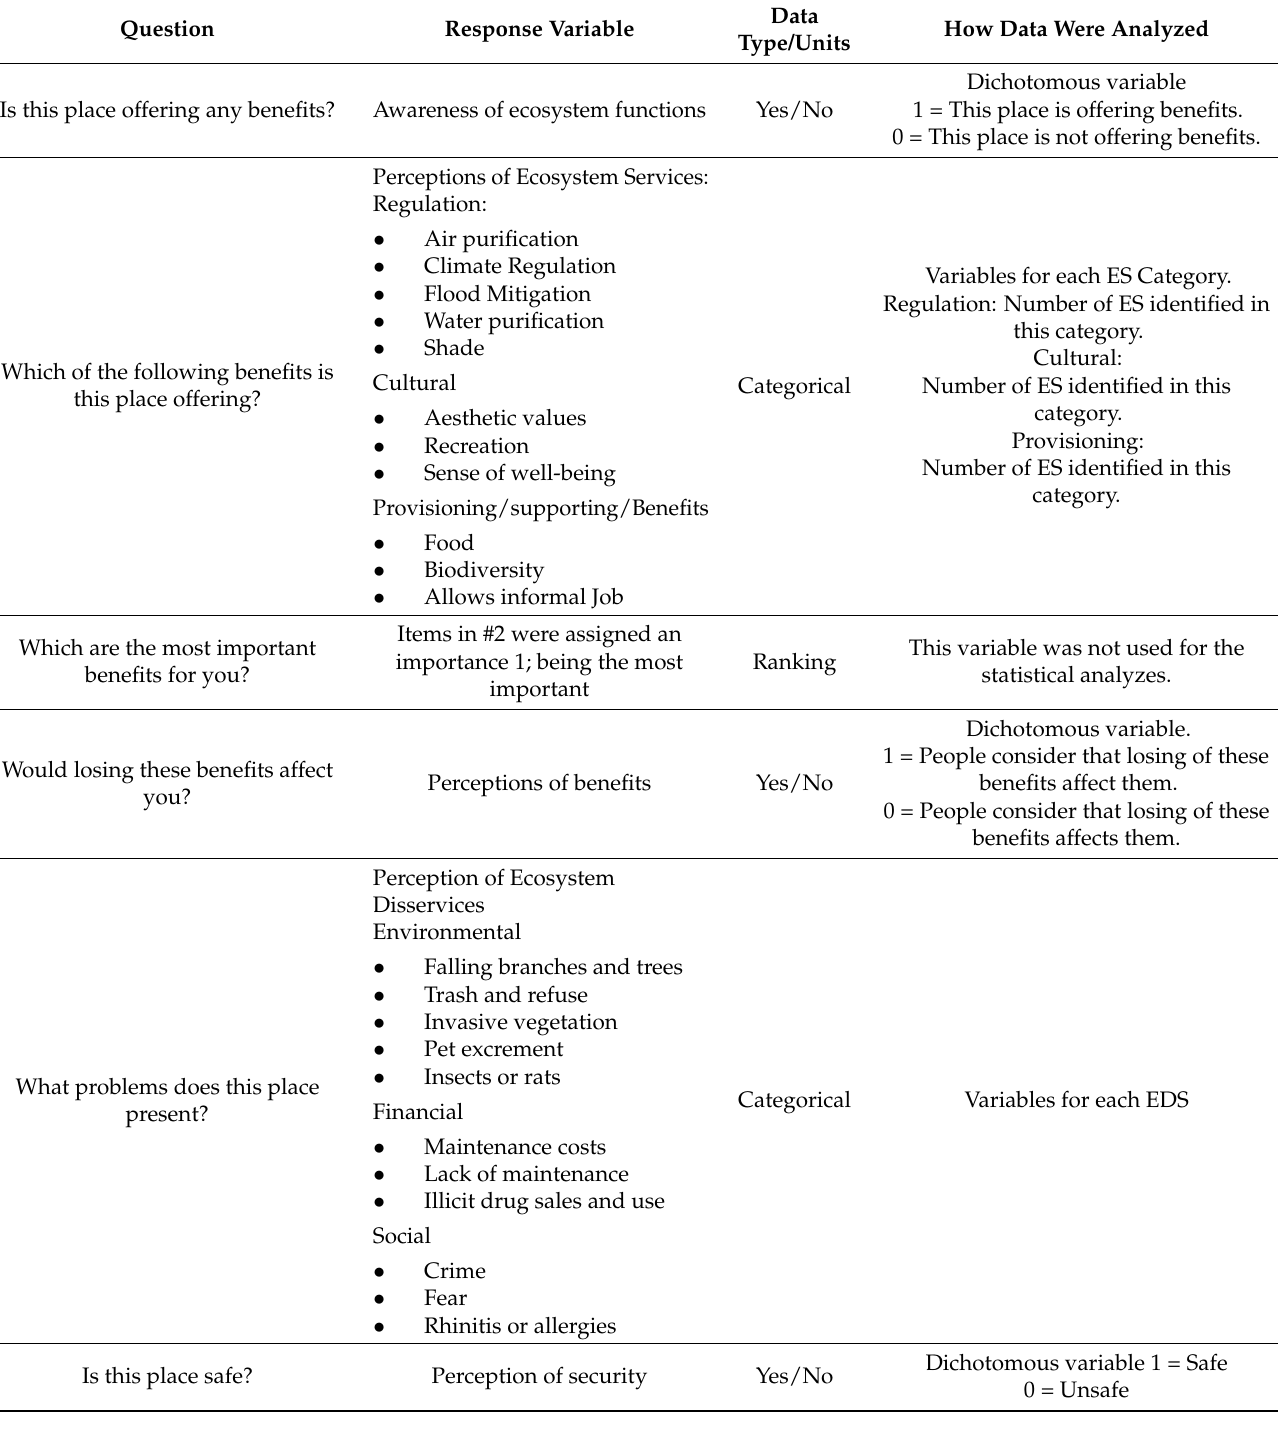
Table A1. Table listing response variables, units, and data types for the survey instrument presented in Supplementary Material A. Note: Only analyzed responses and variables are